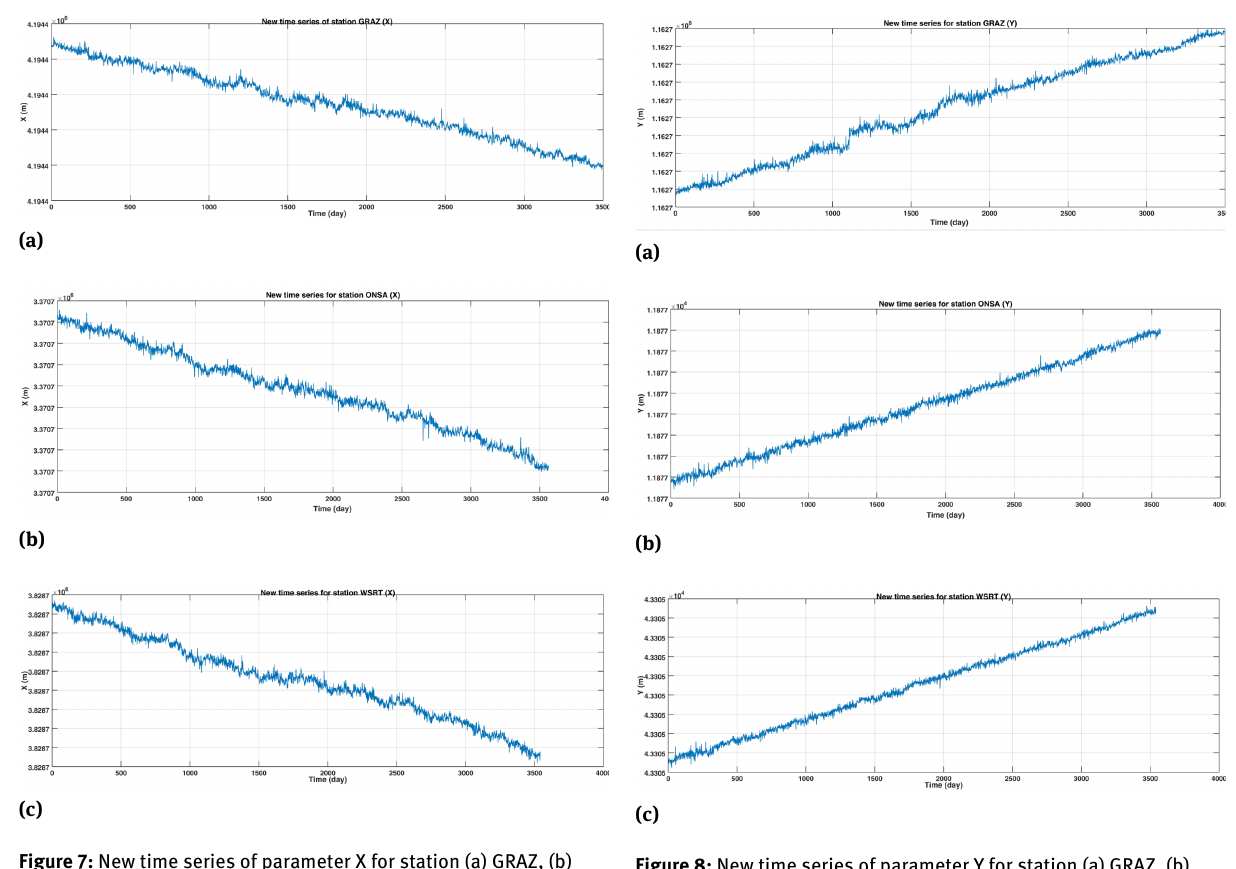
Figure 8: New time series of parameter Y for station (a) GRAZ, (b) ONSA, (c)